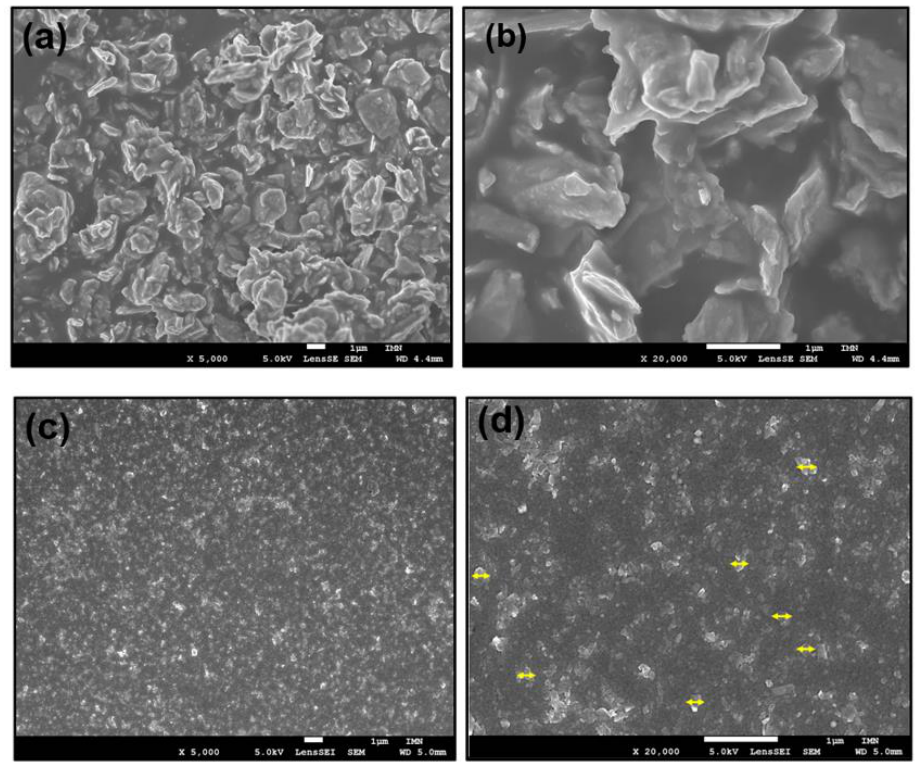
Figure 3. FESEM images of ( a ) MoS 2 nanopowder and ( b ) MoS 2 nanpowder at high magnification, ( c ) exfoliated MoS 2, ( d ) exfoliated MoS 2 at high magnification, and the yellow arrows indicate the grain lateral sizes .